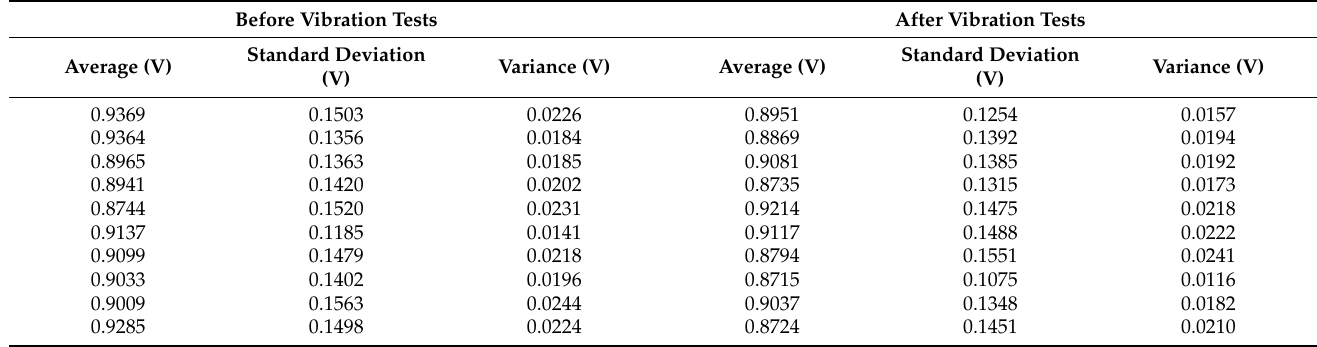
Table 2. Statical experimental data for voltage of PD3, before and after vibration tests.